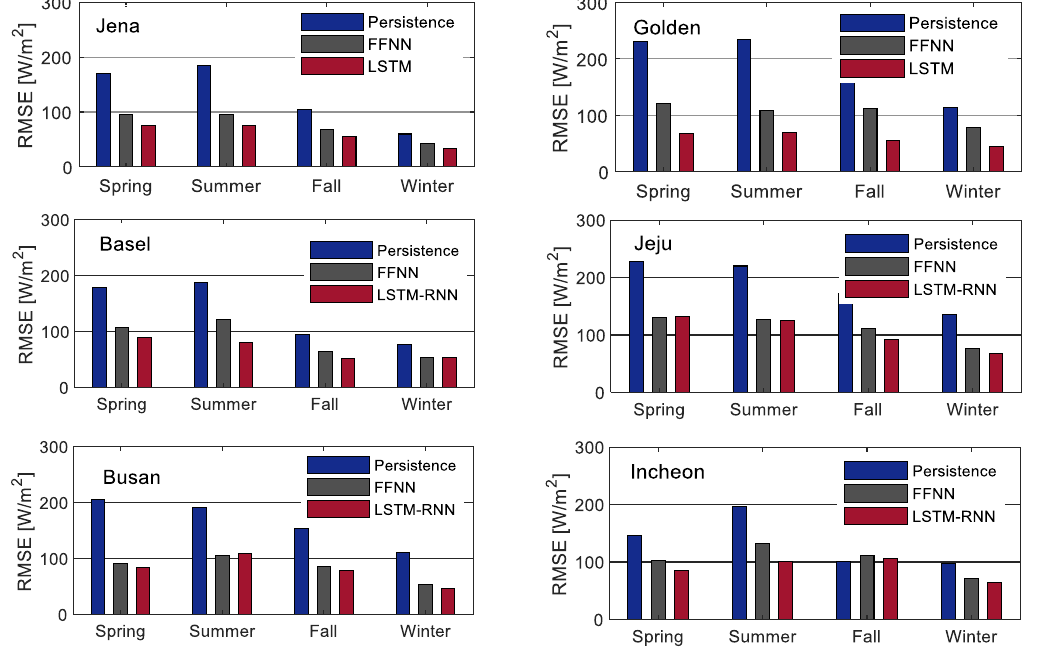
Figure 7. Scatter plots of the measured and predicted solar irradiance for the proposed approach.